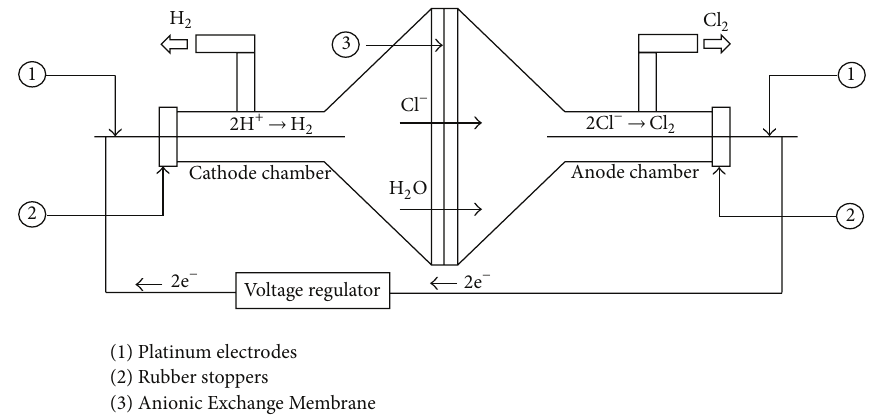
Figure 1: Schematic of the experimental setup used for batch electrolytic process of hydrochloric acid.